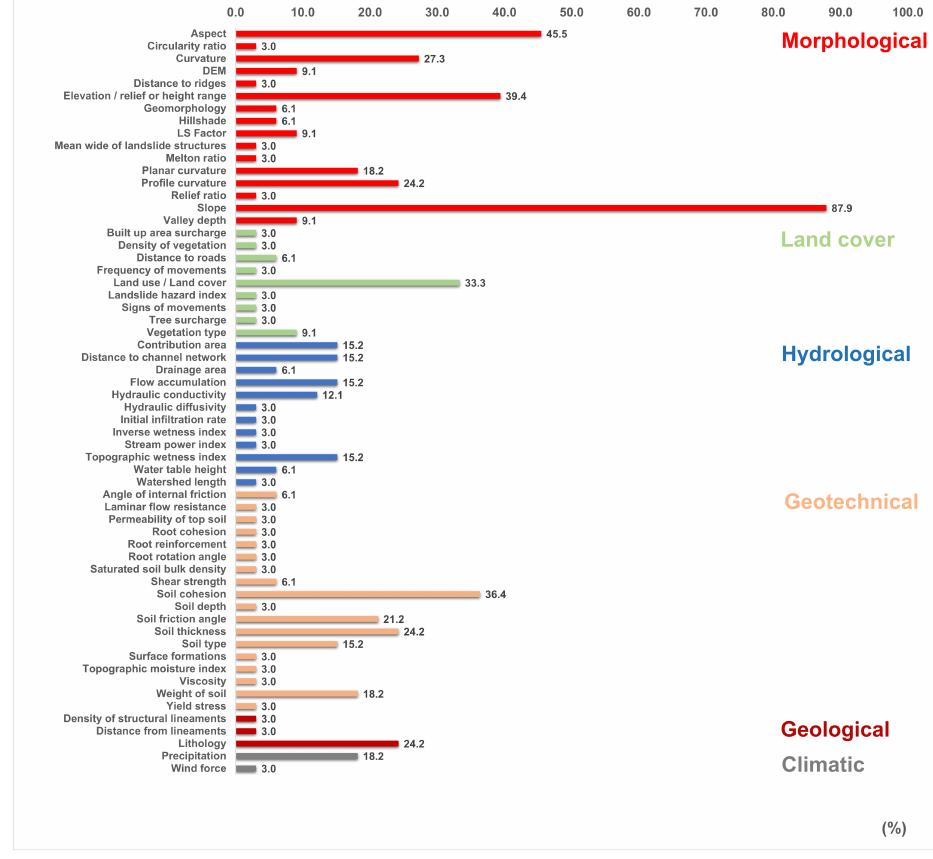
Figure 7. Thematic variables used in landslide susceptibility assessment in